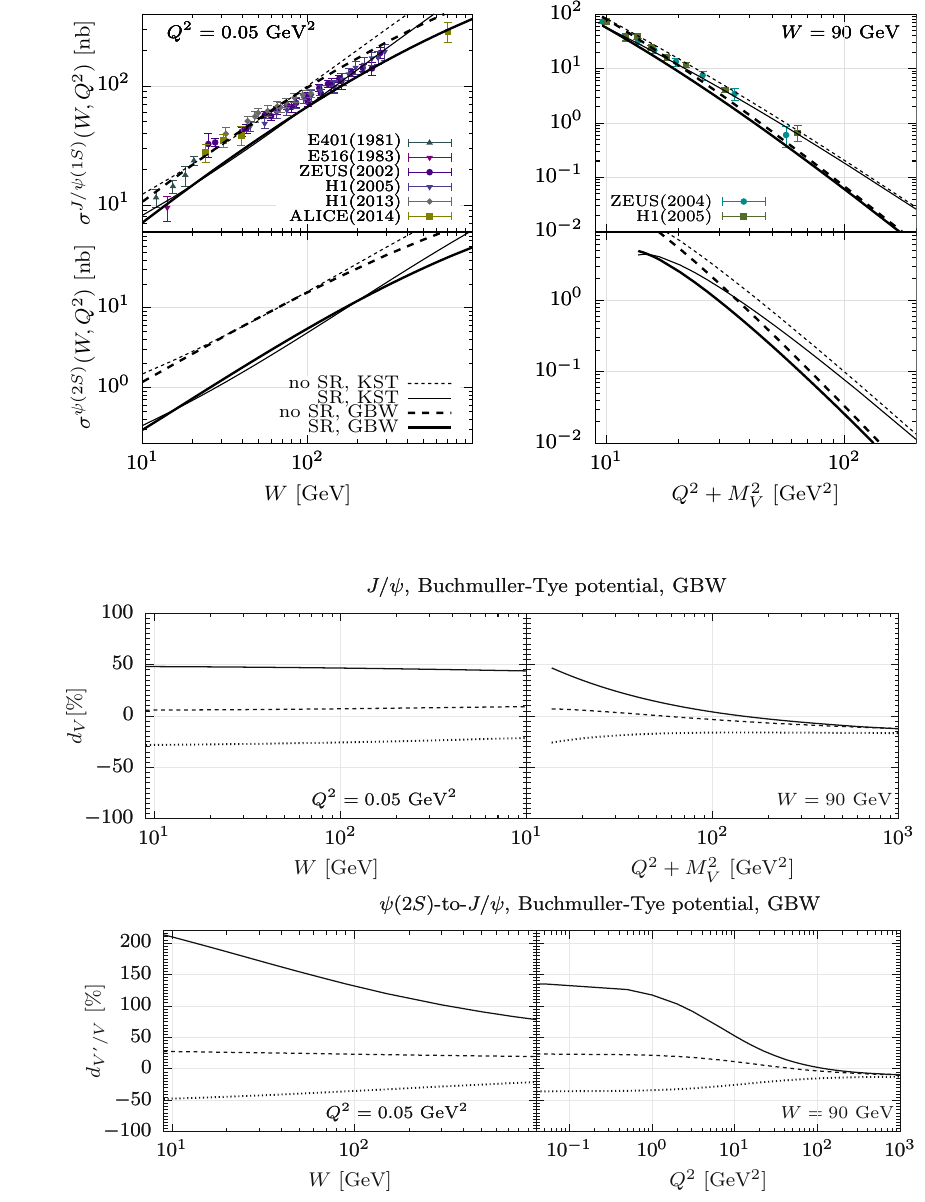
Fig. 2 The same as Fig. 1, except using the J /ψ( 1 S ) and ψ (cid:4) ( 2 S ) radial wave functions computed with the power-like Q ¯ Q potential [37]